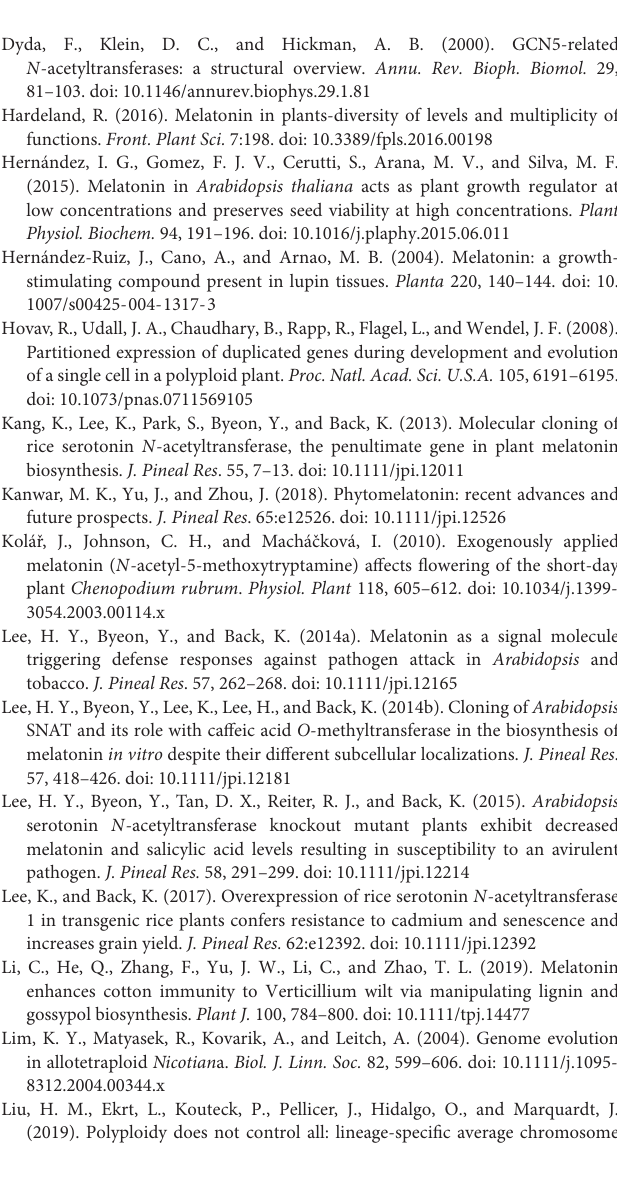
Supplementary Figure 1 | Conserved amino acid sequences of 12